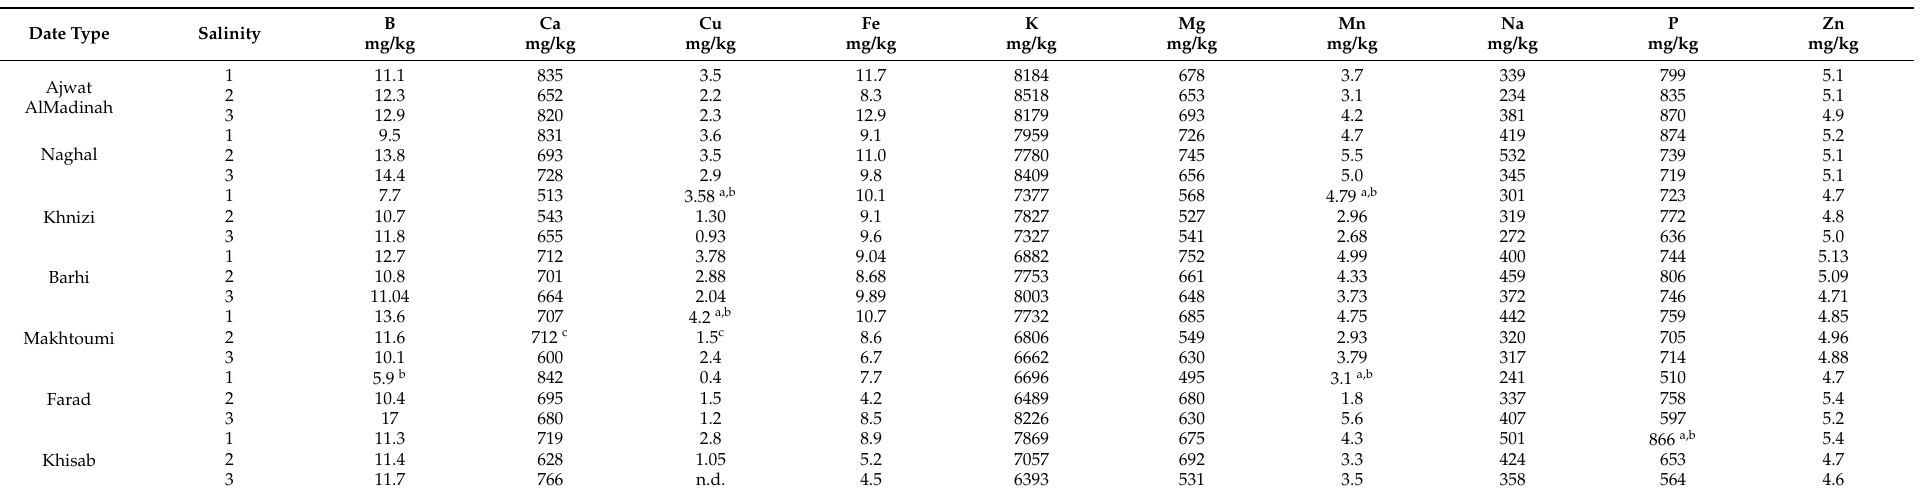
Table 2. The mean concentration of minerals in each date palm variety at three salinity